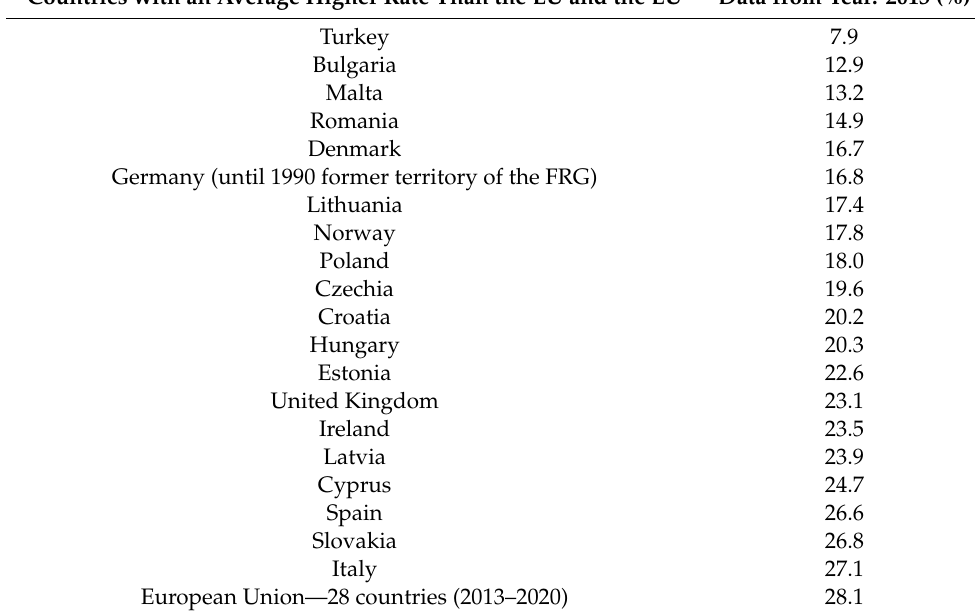
Table A5. Persons reporting exposure to risk factors that can adversely a ff ect mental wellbeing (Eurostat 2013).